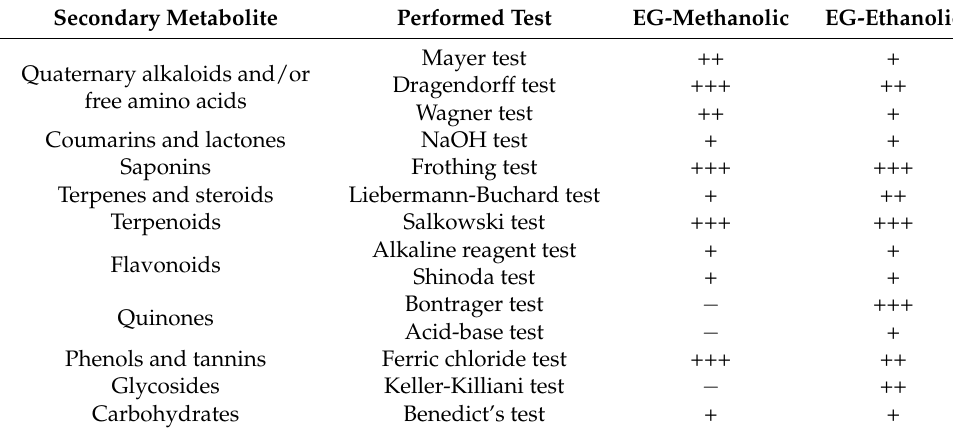
Table 2. Phytochemical screening of methanolic and ethanolic